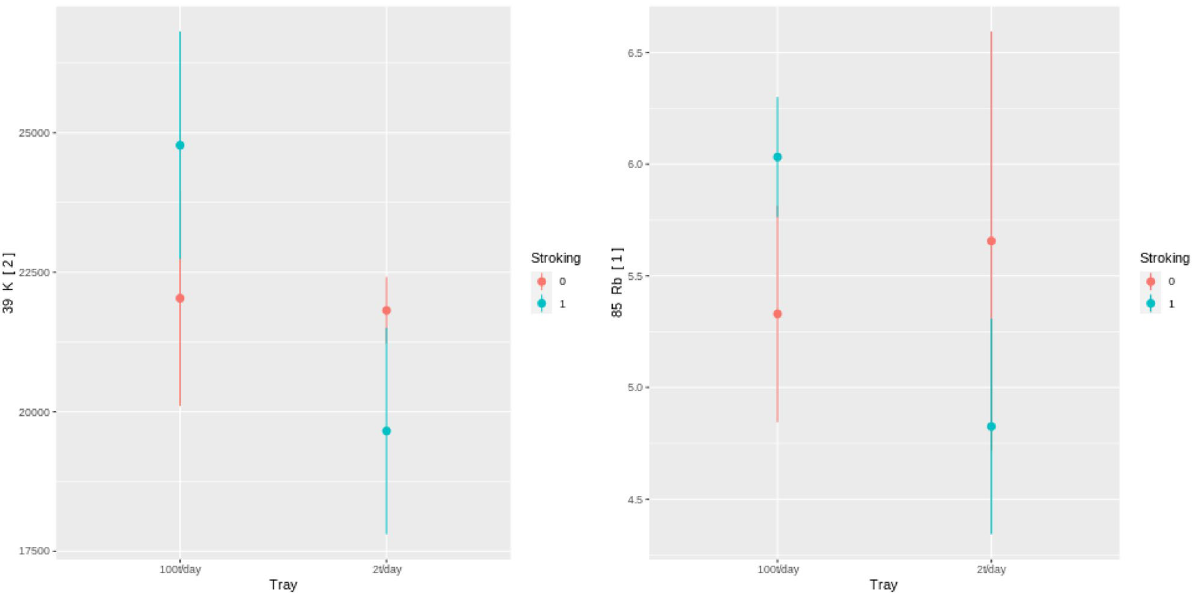
Figure 11. Average levels and 95% interval of K and Rb ( µ g/g) for the eight collected samples in the two treatment groups (100 t/day and 2 t/day for stroking = 1) and two control groups (stroking =